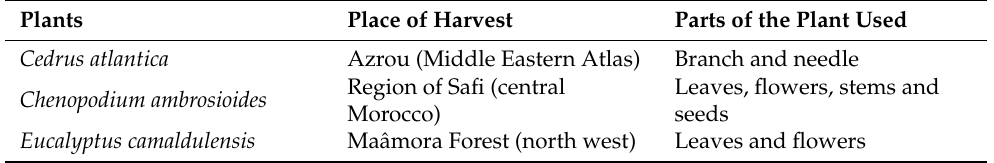
Table 6. Place of harvest and plant parts used for extraction. Plants Place of Harvest Parts of the Plant Used Cedrus atlantica Azrou (Middle Eastern Atlas) Branch and needle Region of Safi (central Leaves, flowers, stems and Chenopodium ambrosioides Morocco) seeds Eucalyptus